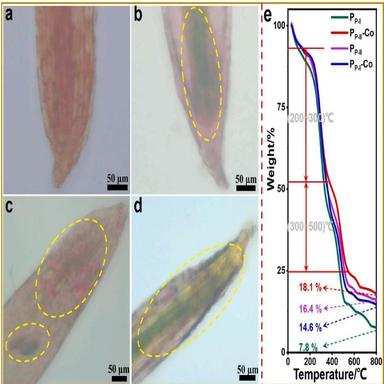
The confocal laser scanning microscope and thermogravimetric curves of Pistia stratiotes roots after growing 36 days in different culture solution: a) Hoagland nutrient solution, b) Co2+culture solution, c) nano-PS particles culture solution, d) nano-PS particles, and Co2+ culture solution; and e) thermogravimetric curves.